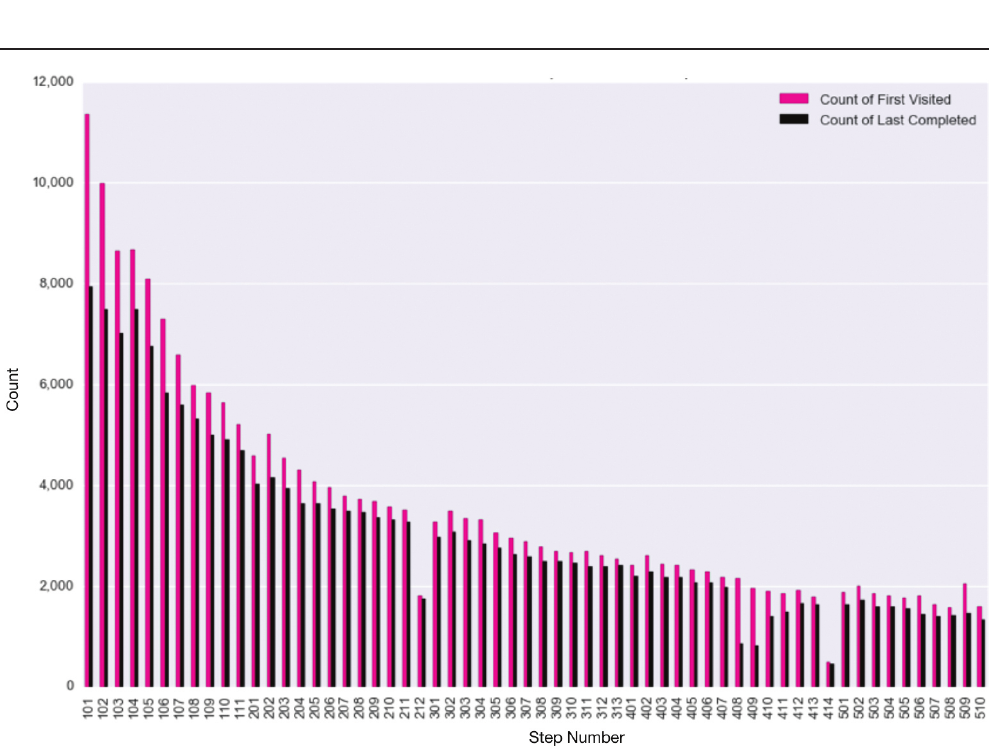
Figure 4: BLE1 Combined count of steps visited and